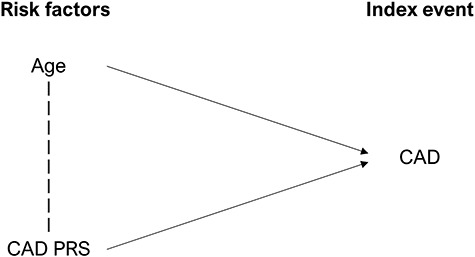
A directed acyclic graph displaying an index event CAD status, with two risk factors: increased age and CAD PRS. The dotted line between Age and CAD PRS indicates that when conditioning on the index event, associations are likely to be induced between the two risk factors. For example, if an individual develops CAD at the age of 20, this suggests that they are likely to have a high CAD PRS.